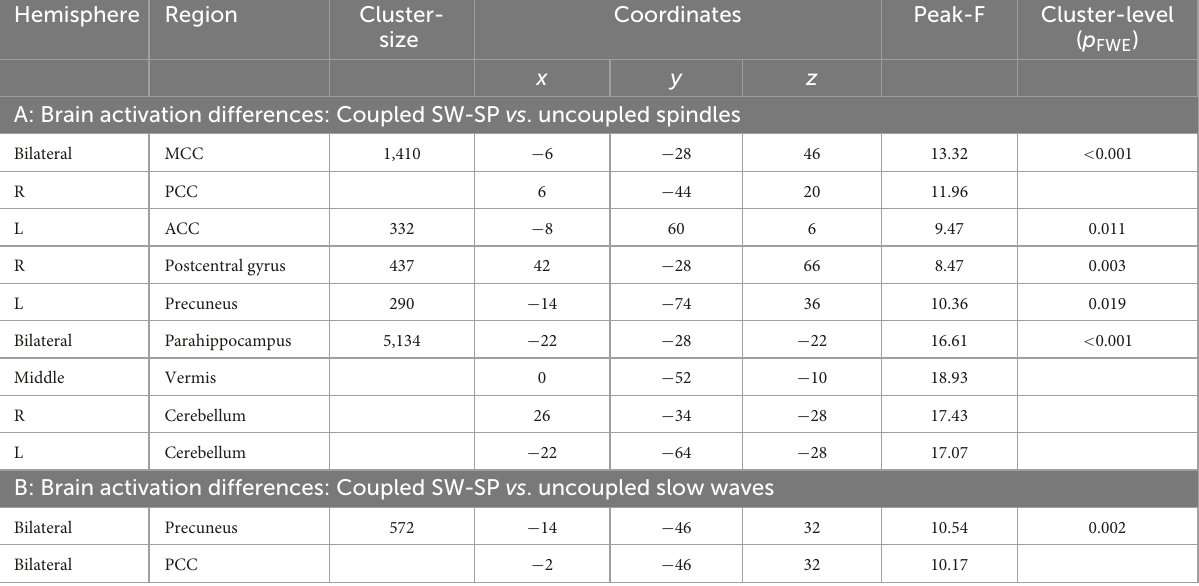
TABLE 3 Differences in cerebral activations between: (A) coupled SW-SP vs. uncoupled spindles, and (B) coupled SW-SP and uncoupled slow waves. Hemisphere Region Cluster- Coordinates Peak-F Cluster-level size x y